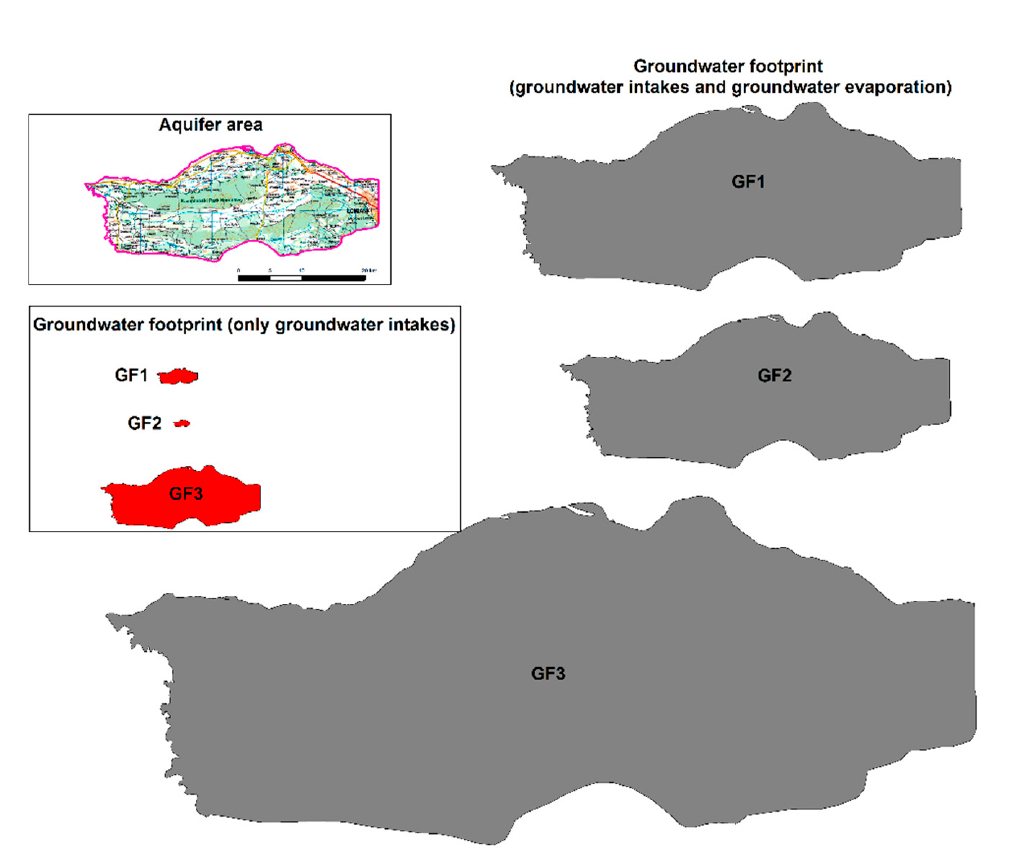
Figure 11. Groundwater footprint of aquifer in the variant: GF1: variant 1; GF2: variant 2; GF3: variant 3.